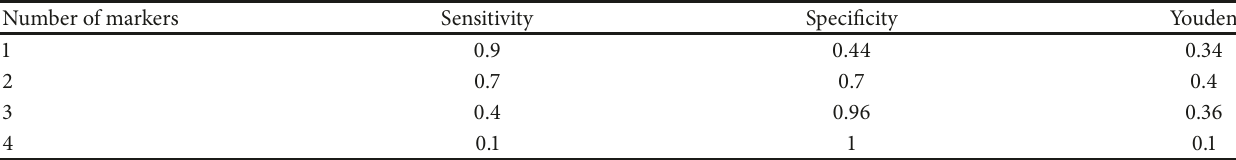
Table 6: Sensitivity, specificity, and Youden score for combined